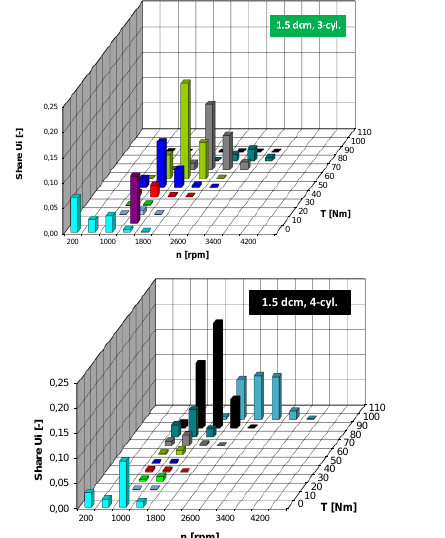
9 of 13 Figure 6. Battery charging and discharging conditions: ( a ) Li-ion (newer, 3-cylinder solution) and Ni-MH (older 4-cylinder solution); ( b ) power characteristics of the batteries. The nominal values of voltage were close to the ones declared by the manufacturer,